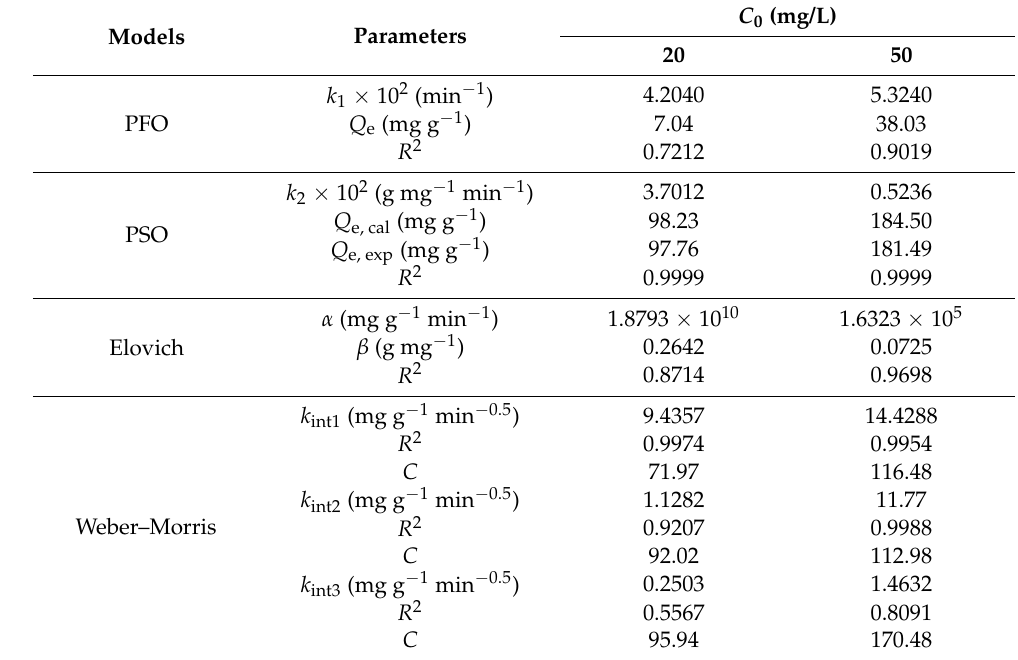
Figure 9. Linear kinetic models of F − adsorption on LMF11 NFs, ( a ) PFO, ( b ) PSO, ( c ) Elovich and ( d ) W-M model. Table 3. Kinetic constants for defluoridation on LMF11 NFs.